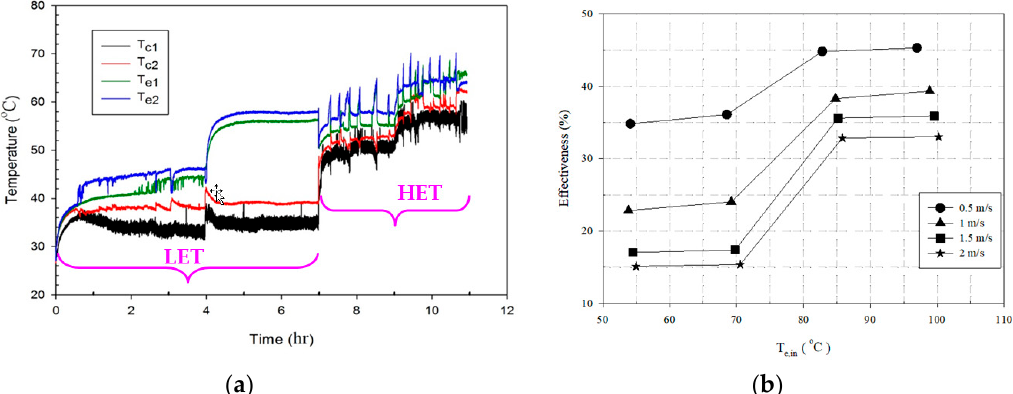
Figure 9. For water-charged PHP heat exchanger with filling ratio of 50% at airflow velocity ranging from 0.5 to 2.0 m/s, the ( a ) variation of surface temperature in both evaporating and condensing sections with time at hot air inlet temperatures stepwise increased from 55 to 100 °C, and ( b ) effectiveness versus the evaporator temperature.